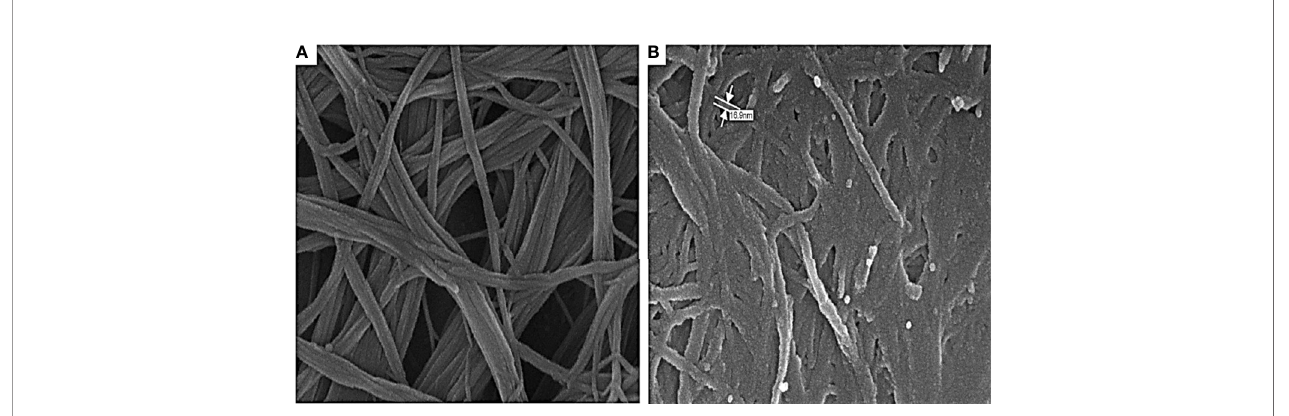
FIGURE 2 | SEM results of (A) COOH-SWCNTs (single-walled carbon nanotubes) and (B) COOH-SWCNTCSPEPs (Chitosan-carbon nanotubes with nonapeptides).